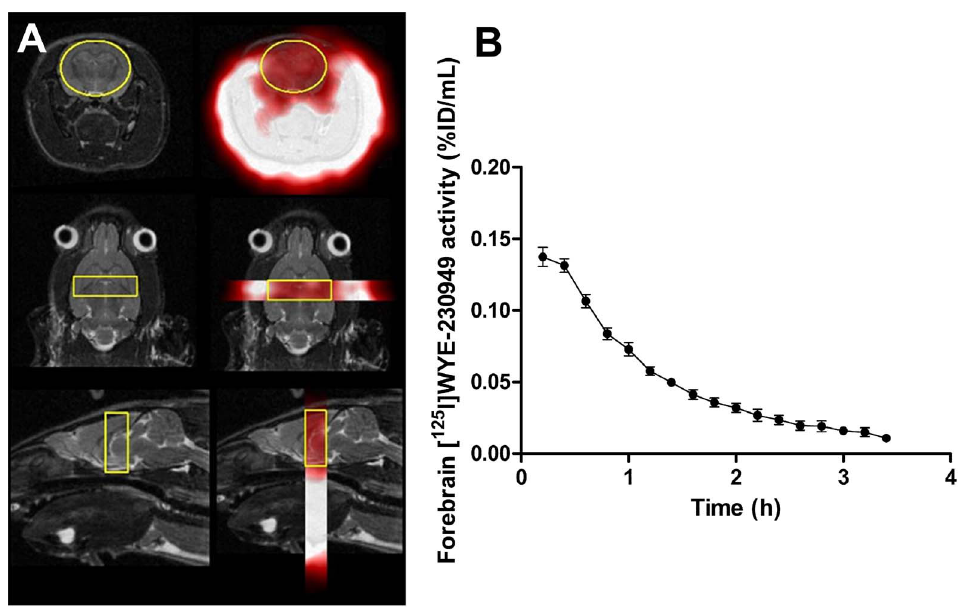
Fig. 3. High Resolution microSPECT/MRI imaging after intravenous injection of [ 125 I]WYE-230949. (A) coronal (top), horizontal (middle) and sagittal (bottom) slices showing the region of interest indicated on the T2* image (left column) and co-registration with the SPECT image (right column). (B) Time activity curve of radioactivity measured in the region of interest (n 5 5). *brain tissue density taken as 1.05 g/ml.